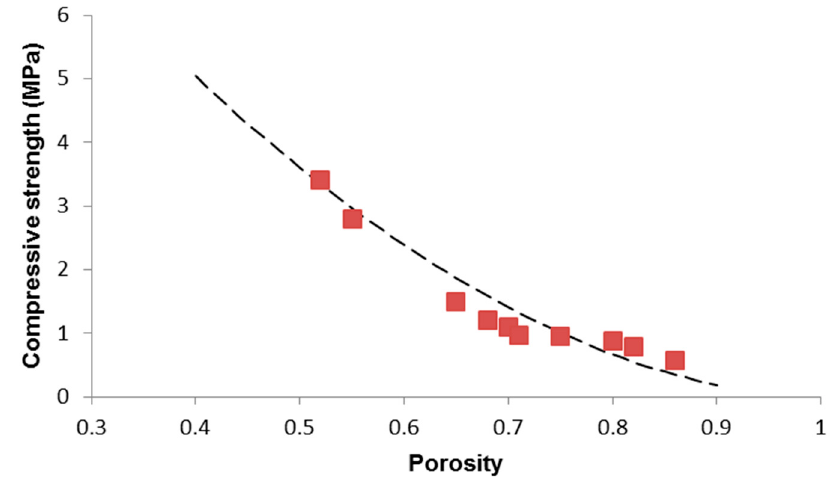
Figure 7. Porosity dependence of compressive strength in 45S5 glass-derived foams with data interpolation by applying the Gibson–Ashby power-law model (Equation (11)).